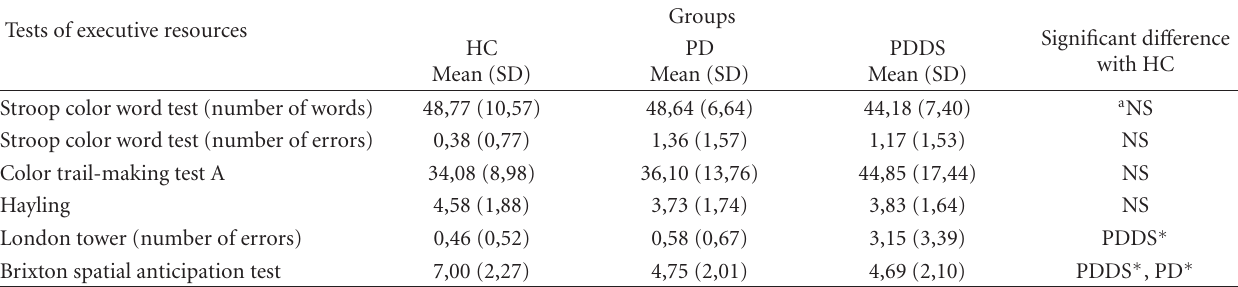
Table 2: Neuropsychological performance of healthy controls (HCs) and participants with Parkinson’s disease with (PDDS) and without (PD) depressive